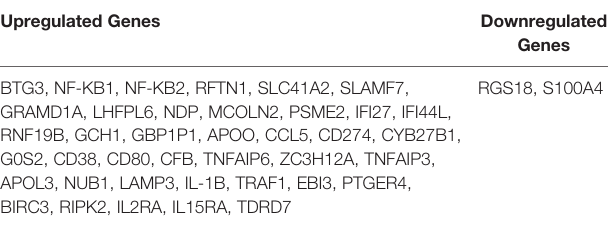
TABLE 5 | Summary of differentially expressed genes in